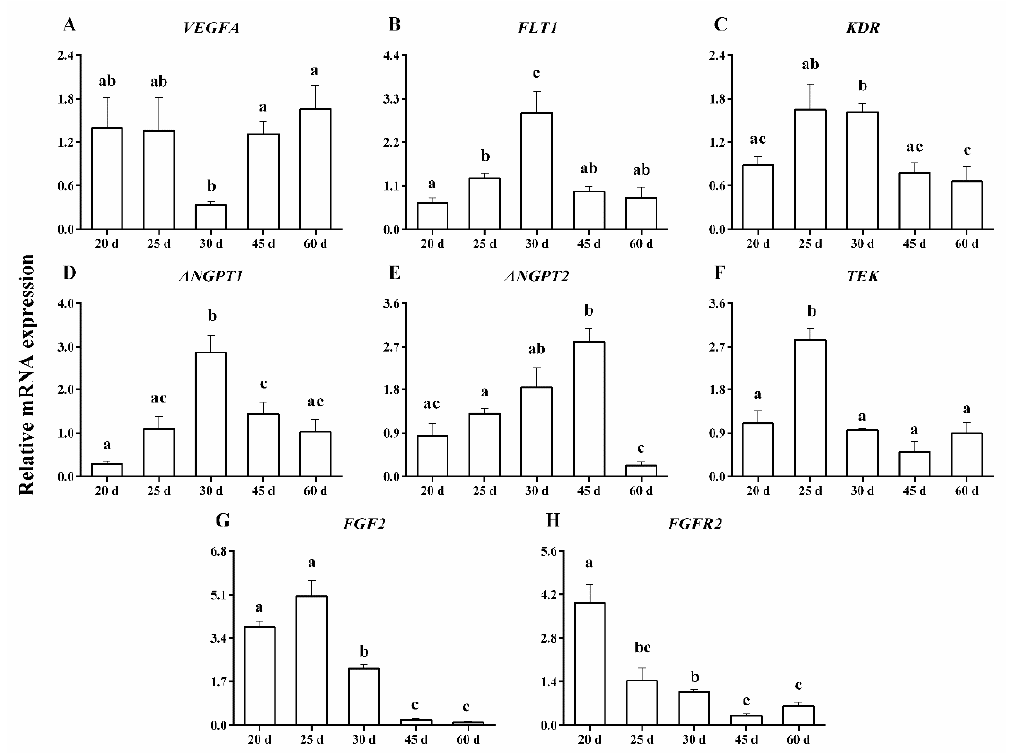
Figure 3A–H show the mRNA expression of VEGFA , FLT1 , KDR , ANGPT1 , ANGPT2 , TEK , FGF2 and FGFR2 . The mRNA expression of VEGFA was lowest on day 30, which was 3.9- to 5-fold lower than on days 45–60 of pregnancy ( p < 0.02) (Figure 3A). How- ever, the mRNA expression of FLT1 was highest on day 30, which was 2.2- to 4.3-fold higher than on days 20–25 and 45–60 of pregnancy ( p < 0.05) (Figure 3B). The mRNA expression of KDR was 2- to 2.5-fold higher on days 30 than on days 20 and 45–60 of pregnancy ( p < 0.02) (Figure 3C). The mRNA expression of ANGPT1 increased by 2- to 9.6-fold on day 30, compared with days 20–25 and 45–60 of pregnancy ( p < 0.02) (Figure 3D). The mRNA expression of ANGPT2 increased by 1.5- to 3.3-fold between days 20 and 45, but decreased by day 60 of pregnancy ( p < 0.05) (Figure 3E). The mRNA expression of TEK approximately increased by 2.5- to 5.6-fold on day 25, compared with days 20 and 30–60 of pregnancy ( p < 0.01) (Figure 3F). The mRNA expression of FGF2 decreased gradually during the early stage of pregnancy and was very low on days 45–60 ( p < 0.05) (Figure 3G). The mRNA expression of FGFR2 was approximately 2.7- to 12.3-fold higher on day 20 than on any other day of pregnancy ( p < 0.01) (Figure 3H).